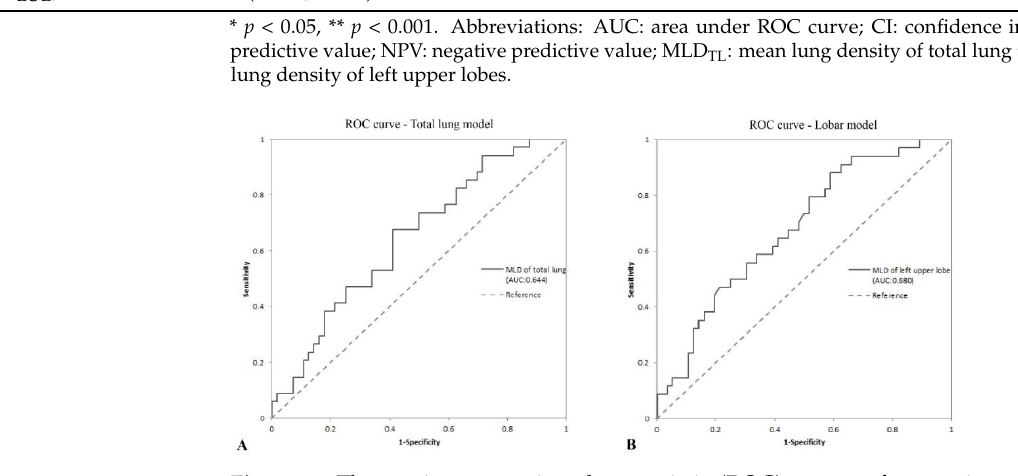
Figure 3. The receiver operating characteristic (ROC) curves of regression models of abnormal diffusion function prediction: ( A ) the ROC curve of total lung model; ( B ) the ROC curve of lobar model.